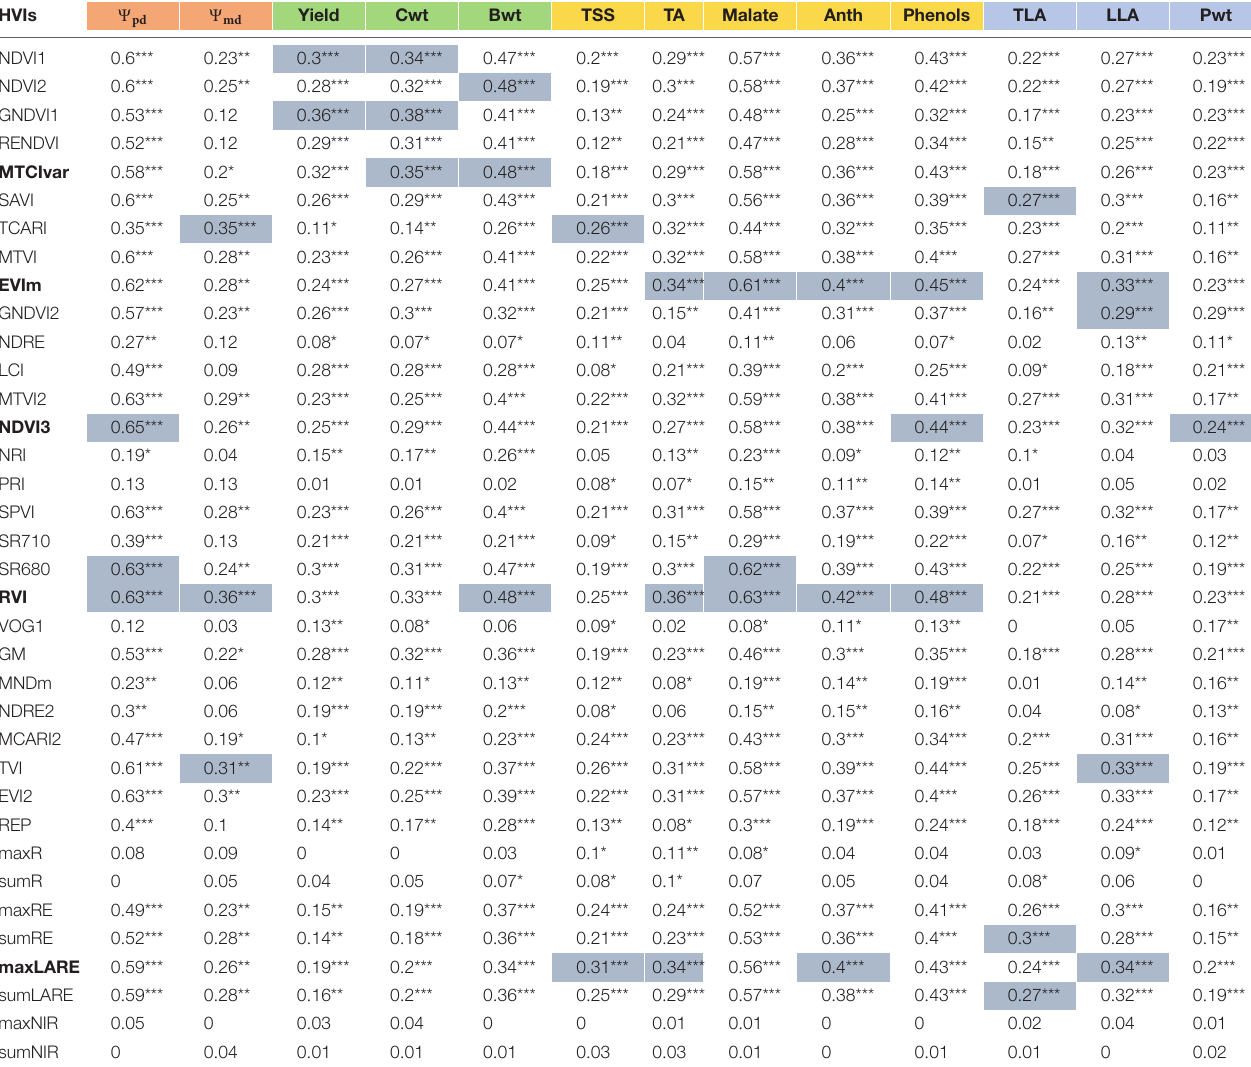
TABLE 3 | Coefficients of determination ( R 2 ) for linear regressions between narrowband HVIs and ground